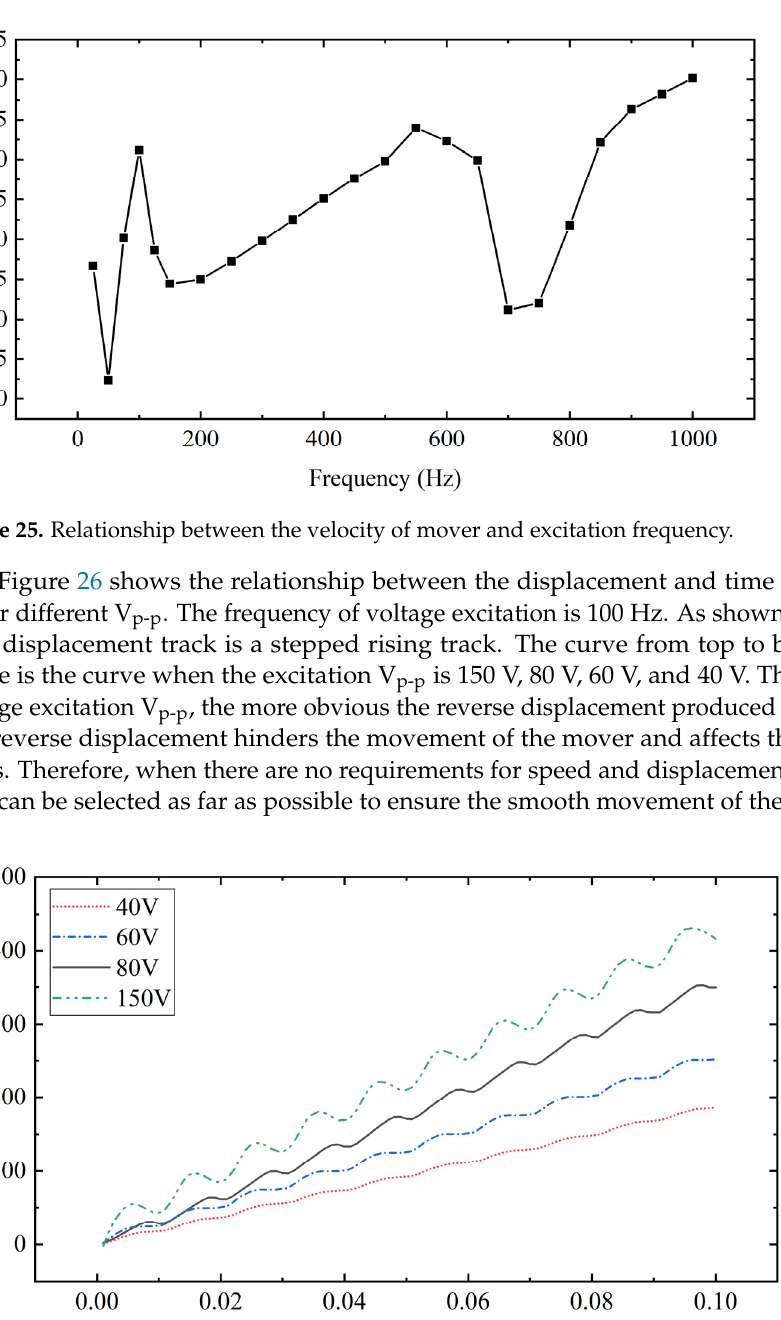
Figure 24. Relationship between mover velocity and oblique wave symmetry.